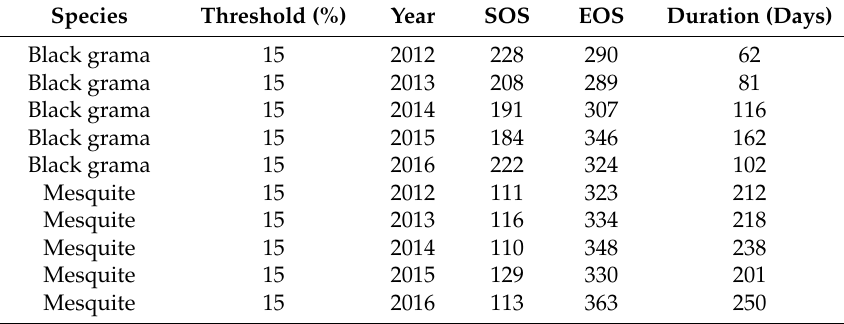
Table A1. SOS and EOS dates for black grama and mesquite derived from 3-day phenocam GCC using 15% seasonal amplitude threshold in the Timesat